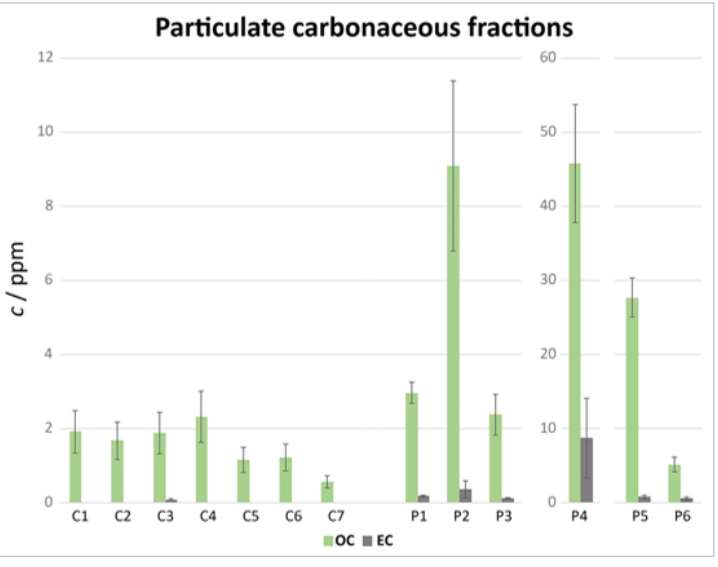
Figure 9. Elaborated TOT results (OC and EC).